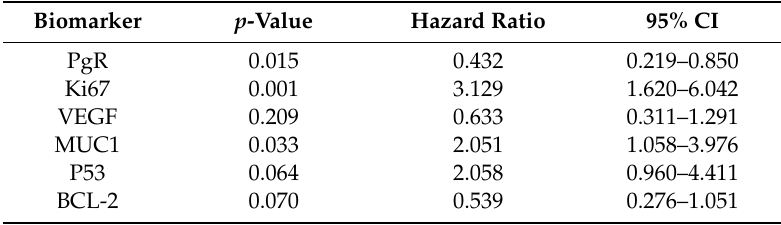
Table 3. Cox regression model for multivariate analysis of biomarkers for breast-cancer-specific survival in older women with ER-positive early operable primary breast